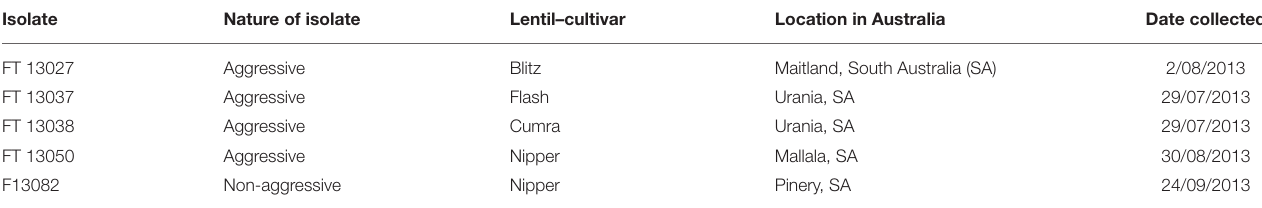
TABLE 1 | Details of A. lentis isolates used in the